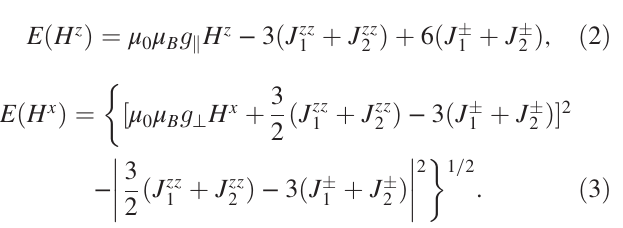
FIG. 4. Experimental versus calculated spin-wave energies, ¼ E where the dashed line denotes E . Fitted exchange expt calc parameters for models A, B, and C are listed in Table I. Models A (Ref. [61]), B (Ref. [43]), and C (global fit to the TDTS and THz data) are represented by orange, green, and blue symbols, respectively. Model B* (global fit to data under the J 2 ¼ 0 constraint) is represented by pink